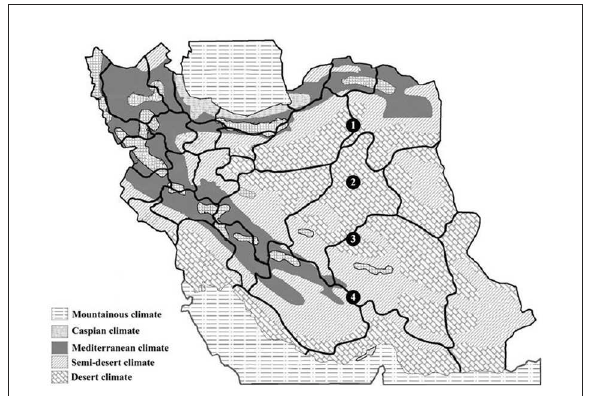
FIGURE1 Location of sampling sites on Iran climatic map, from 1 to 4. All samples were taken from semi-arid and arid desert climate regions along a latitudinal gradient. Sampling sites are shown with black circles and for precise location of sampling areas